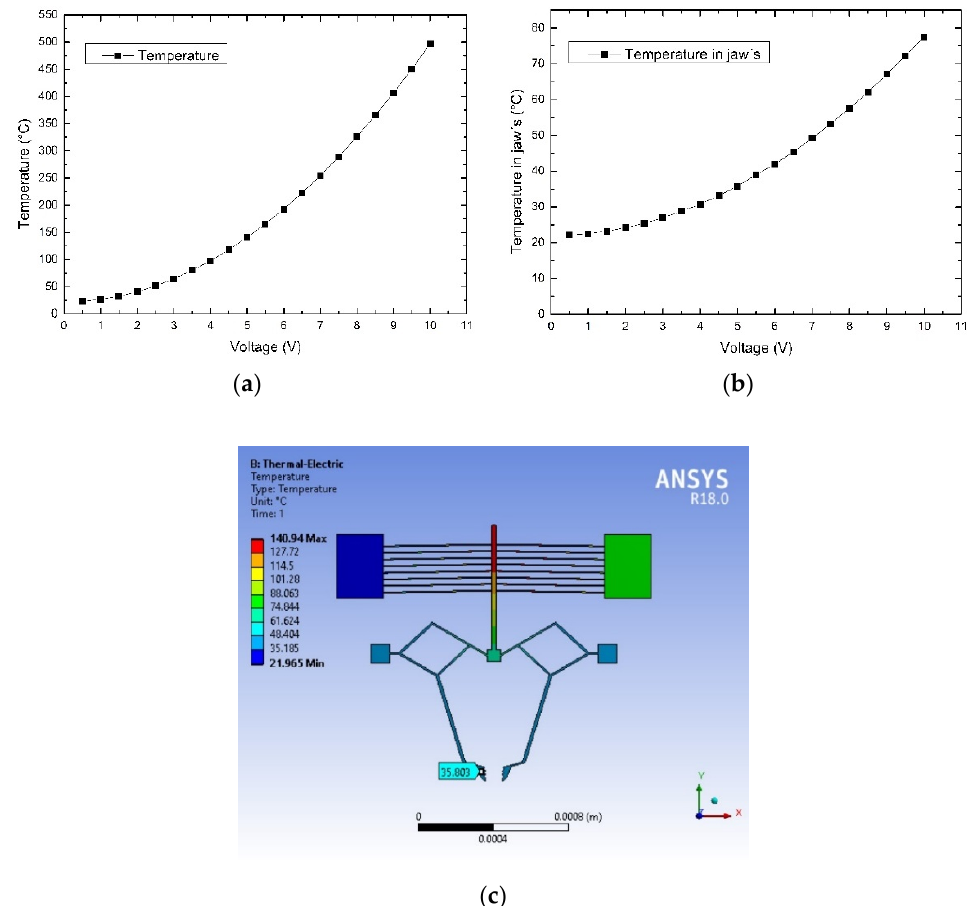
Figure 8. Temperature at ( a ) shuttle and ( b ) jaw’s microgripper vs. applied voltage. ( c ) Temperature distribution of initial microgripper @ 5 V .